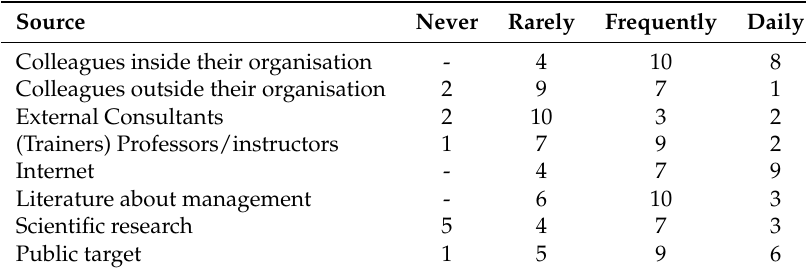
Table 2. Frequency on consultation of knowledge sources.